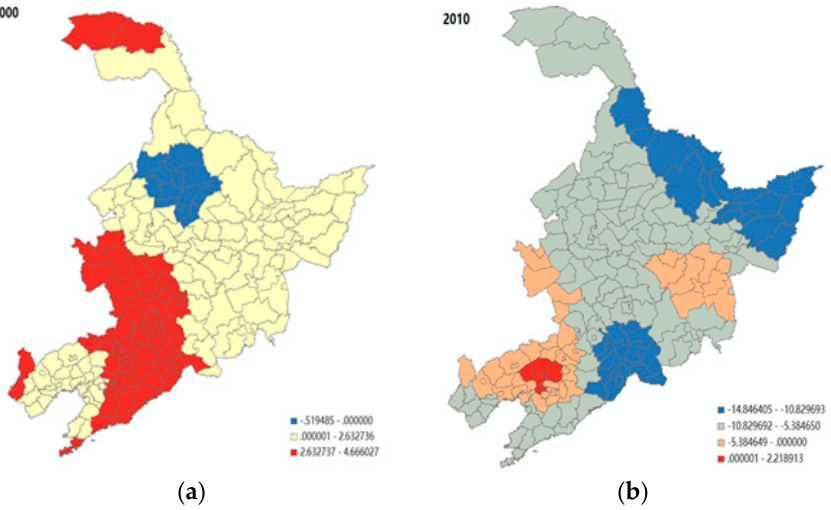
Figure 7. The spatial variability of the effect of healthcare conditions and population mobility on population ageing. ( a ) Healthcare conditions in 2000; ( b ) Population mobility in 2010. Note: the coefficients of healthcare conditions were not significant for all cities in 2010; the coefficients of population mobility were significant in the northern border of Jilin, eastern Jilin, and eastern Liaoning.